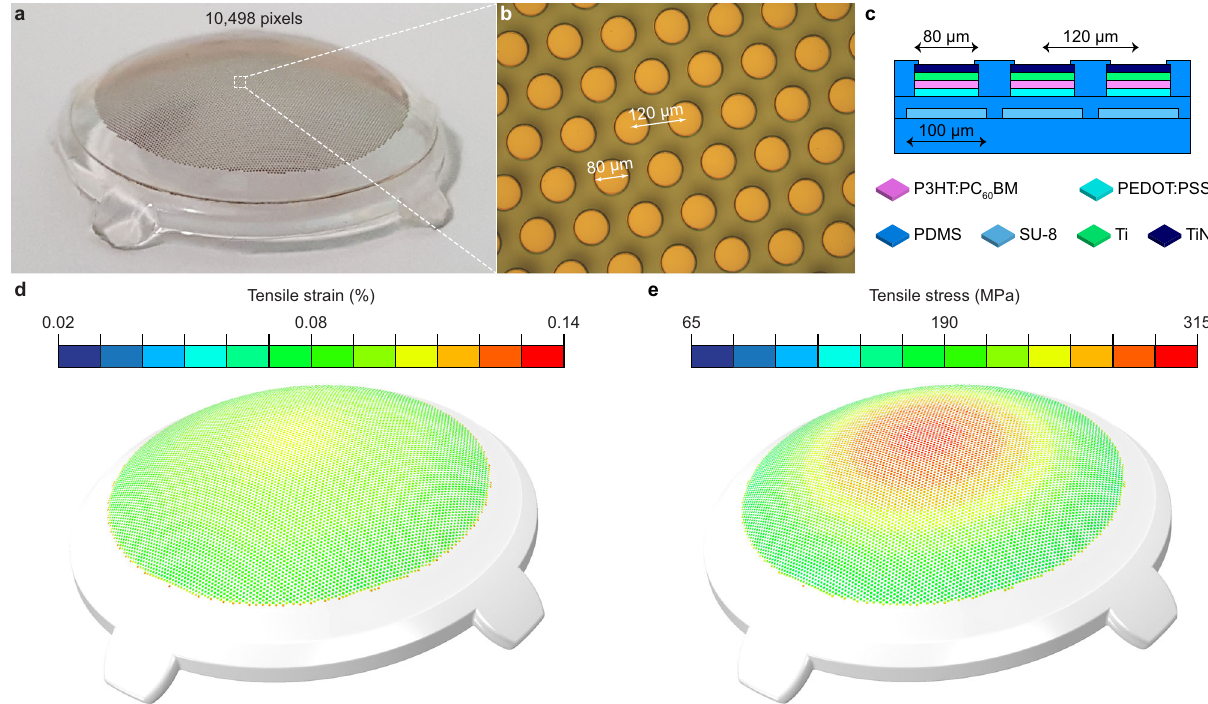
Fig. 1 High-density POLYRETINA device. a Picture of the high-density POLYRETINA prosthesis with 10,498 photovoltaic pixels. b Magni fi ed view of the 80- µ m diameter and 120- µ m pitch photovoltaic pixels. c Sketch of the cross-section structure of the POLYRETINA photovoltaic interface before bonding to the hemispherical dome. The layer ’ s thicknesses are as follow base PDMS layer: 50 μ m; SU-8 platforms: 6 μ m; second PDMS layer embedding SU-8 platforms: 15 µ m; PEDOT:PSS: 50 nm, P3HT:PCBM: 100 nm, Ti-TiN: 80 – 60 nm, fi nal PDMS layer: 4 μ m. PDMS polydimethylsiloxane, PEDOT poly(3,4- ethylenedioxythiophene), PSS poly(styrenesulfonate), P3HT regioregular poly(3-hexylthiophene-2,5-diyl), PC60BM [6,6]-phenyl-C61-butyric acid methyl ester, Ti titanium, TiN titanium nitride. d Tensile strain simulated at the level of TiN. e Tensile stress simulated at the level of